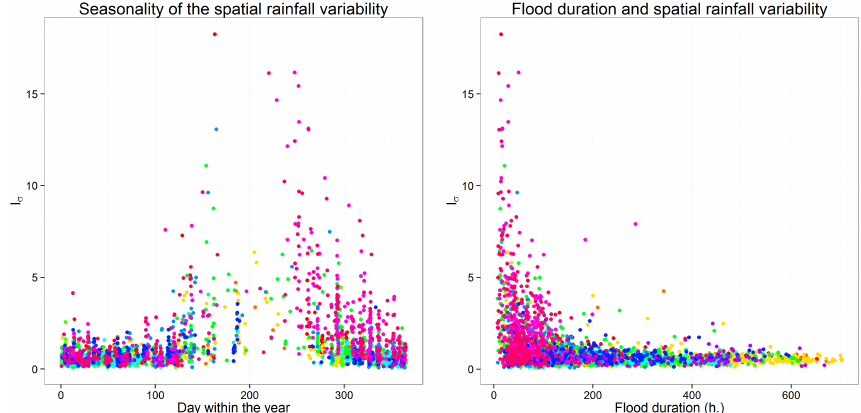
Fig. 8. Relationship between seasonality of the spatial rainfall variability (left panel) and spatial rainfall variability and event duration (right panel) for the 3620 flood events observed. The colors refer to geographic regions, with the same color scheme used in Fig.